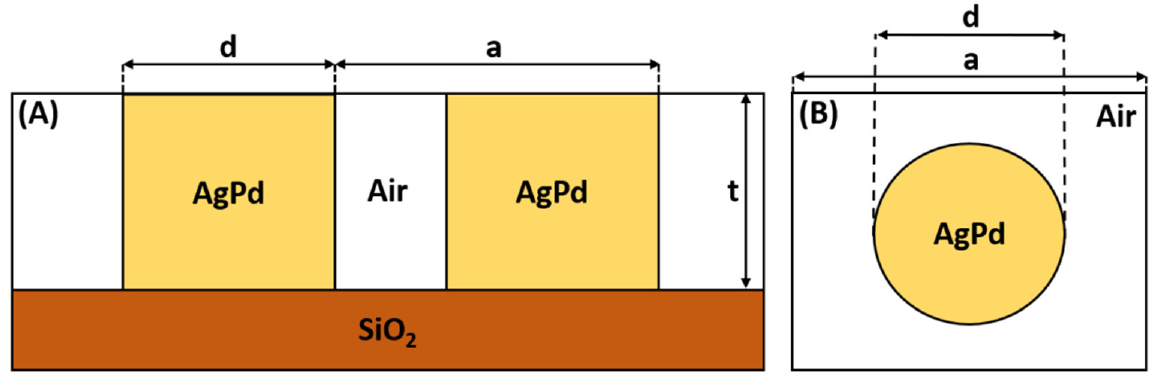
Figure 6. The examined system of AgPd alloy (side view ( A ) and top view ( B )), where a is the lattice constant, d the diameter and t the thickness of the nanoparticles.